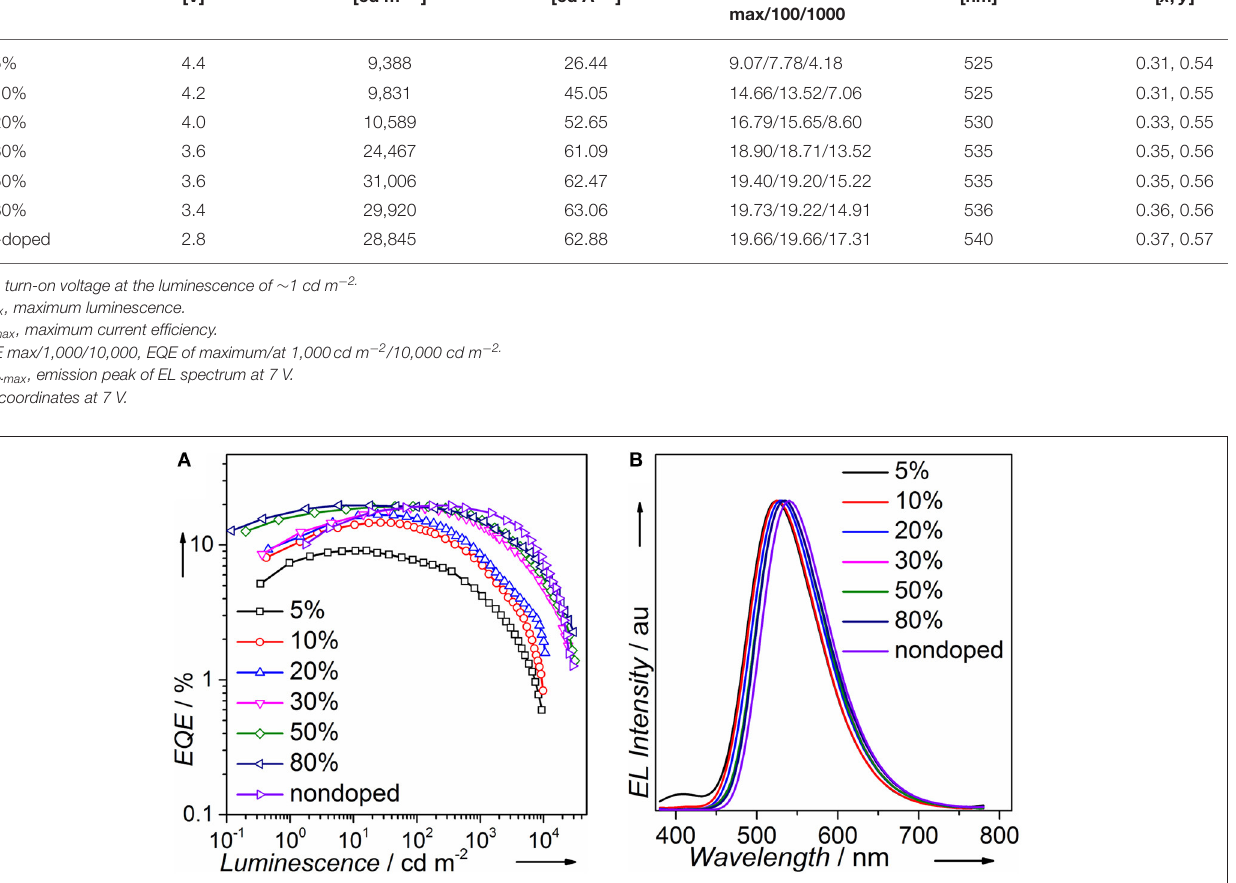
TABLE 2 | EL performance of PTZMes 2 B-based devices. Device